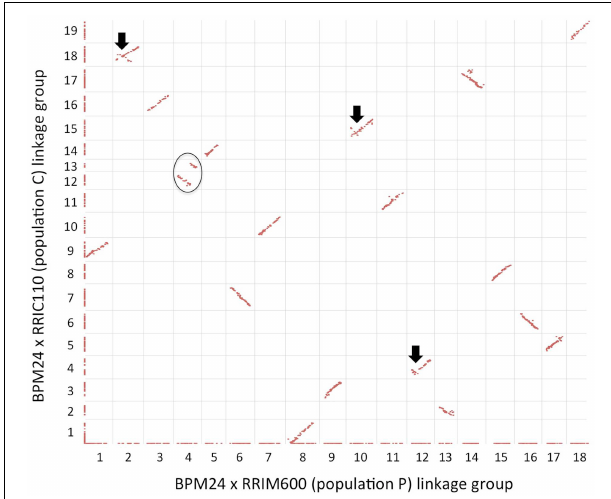
FIGURE 2 | Pairwise comparison between BPM24 × RRIM600 (population P) and BRM24 × RRIC110 (population C) linkage maps. Shared markers are plotted according to their genetic positions on each map, whereas unique markers are plotted along the axes. A black circle indicates two linkage groups (LG12 and LG13) in population C that correspond to a single linkage group in population P (LG4). Black arrows indicate inconsistencies in marker order between the two